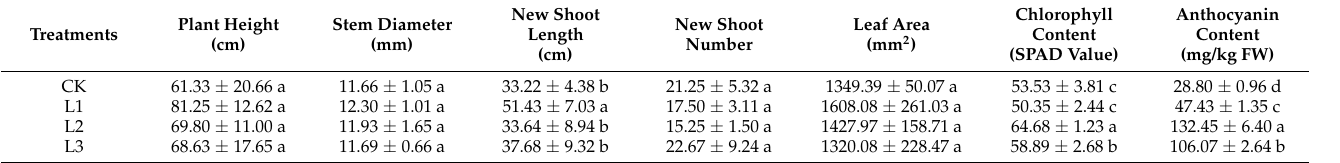
Table 4. Effects of different light qualities on the growth of ‘Misty’ in plant factory with artificial lighting.